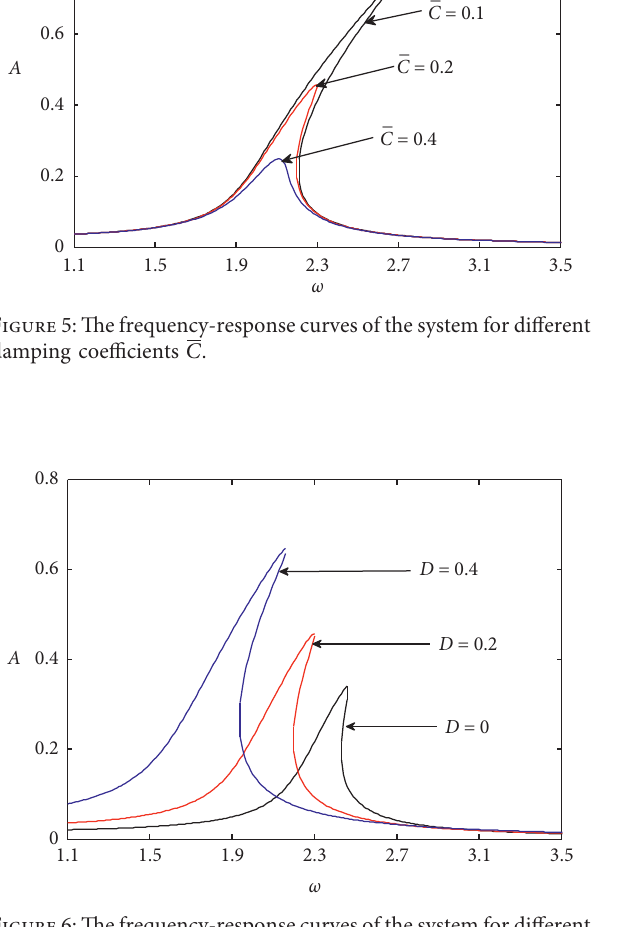
Figure 6: The frequency-response curves of the system for different damage variable D . Figure 7 highlights the size effect on the frequency- response curves of dynamic system. The numerical cal- culations